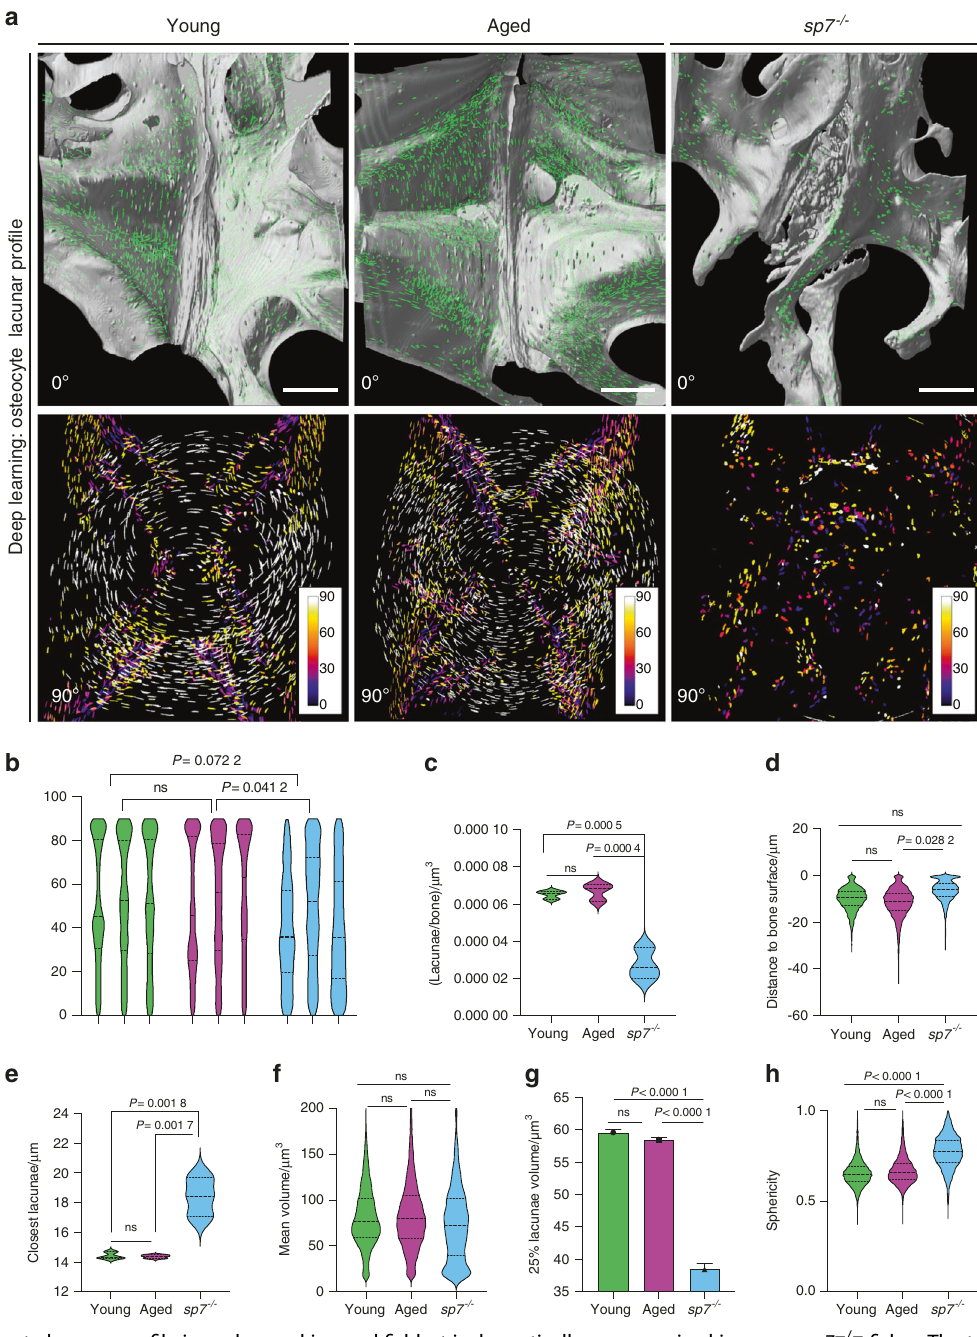
Fig. 4 The osteocyte lacunar pro fi le is unchanged in aged fi shbut is dramatically compromised in young sp7 − / − fi sh. a The top panel presents 3D volumetric rendering and postimaging analysis of young (1 y wt), aged (3 y wt), and sp7 − / − (1 y) (lateral view of the IVD, 0°), showing vertebral bone and segmented lacunae (labeled in green), resulting from automated image segmentation using deep learning. Note the distribution of lacunae at the endplates and along the bone, with a dramatic reduction in sp7 − / − . The bottom panel shows segmented lacunae (90° clockwise rotation from the lateral view of the IVD), color coded to show orientation (angle), with the center of the vertebral centrum as reference for orientation. Scale bars = 50 μ m. b Violin plot of lacunae orientation from the center of the centrum. Data are individual zebra fi sh ( n = 3). Nested one-way ANOVA, post hoc Tukey ’ s multiple comparisons test. P values are indicated. ns nonsigni fi cant. c Violin plot of number of lacunae per volume of bone. One-way ANOVA, post hoc Tukey ’ s multiple comparisons test. P values are indicated. ns nonsigni fi cant. d Violin plot of lacunae distances from the bone surface. Nested one-way ANOVA, post hoc Tukey ’ s multiple comparisons test. P values are indicated. ns nonsigni fi cant. e Violin plot of the distance to the closest lacunae. Data are the mean ( n = 3). Nested one-way ANOVA, post hoc Tukey ’ s multiple comparisons test. P values are indicated. ns nonsigni fi cant. f Violin plot of lacunae volume. Note the subpopulation of lacunae showing a small volume in sp7 − / − zebra fi sh. Data are the mean ( n = 3). Nested one-way ANOVA, post hoc Tukey ’ s multiple comparisons test. P values are indicated. ns nonsigni fi cant. g The top 25% smallest lacunae volume from young (1 y), aged (3 y), and sp7 − / − (1 y) zebra fi sh were compared. One-way ANOVA, post hoc Tukey ’ s multiple comparisons test. P values are indicated. ns nonsigni fi cant. h Violin plot of lacunae sphericity (circularity). Data are the mean ( n = 3). Nested one-way ANOVA, post hoc Tukey ’ s multiple comparisons test. P values are indicated. ns nonsigni fi